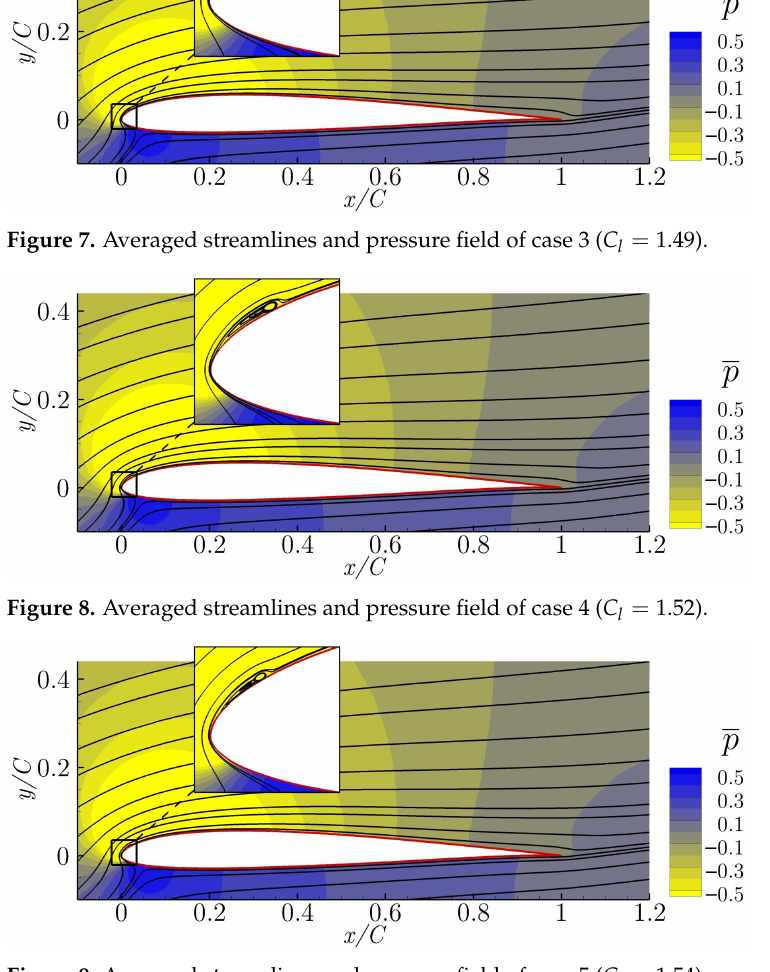
Figure 9. Averaged streamlines and pressure field of case 5 ( C l =